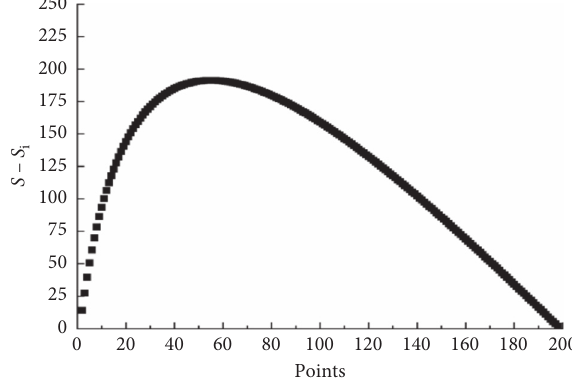
Figure 3: Difference fitting curve of S and S